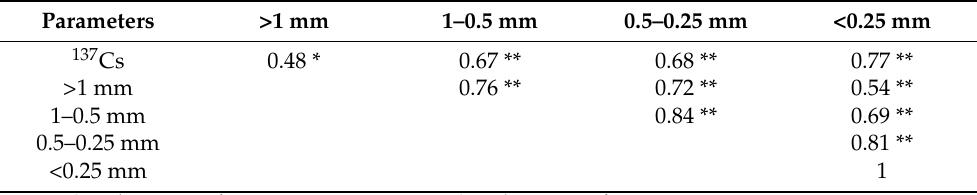
Table 4. Correlation between 137 Cs and organic carbon content of